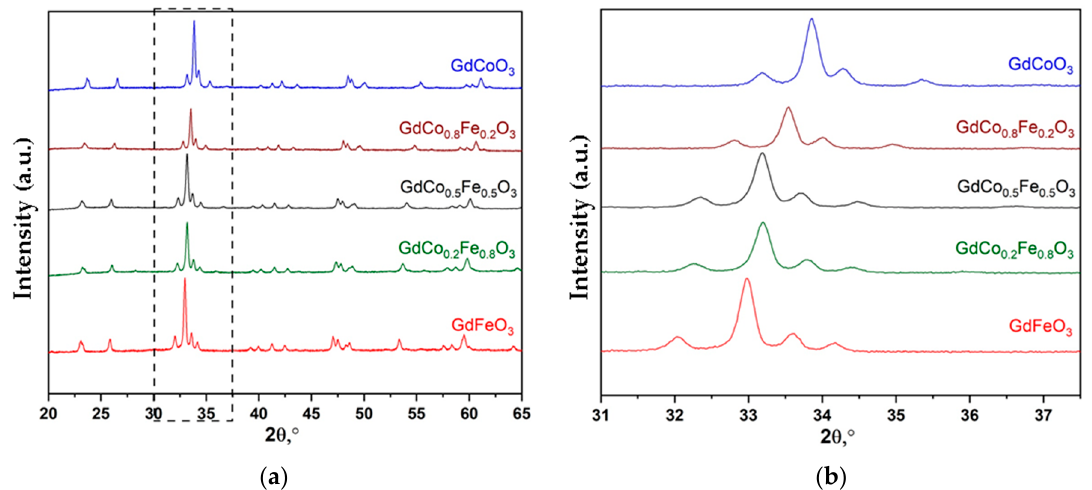
Figure 1. XRD patterns of as-prepared GdFe 1 − x Co x O 3 (x = 0; 0.2; 0.5; 0.8; 1) samples ( a ) full pattern; ( b ) zoom-in on the peak range.